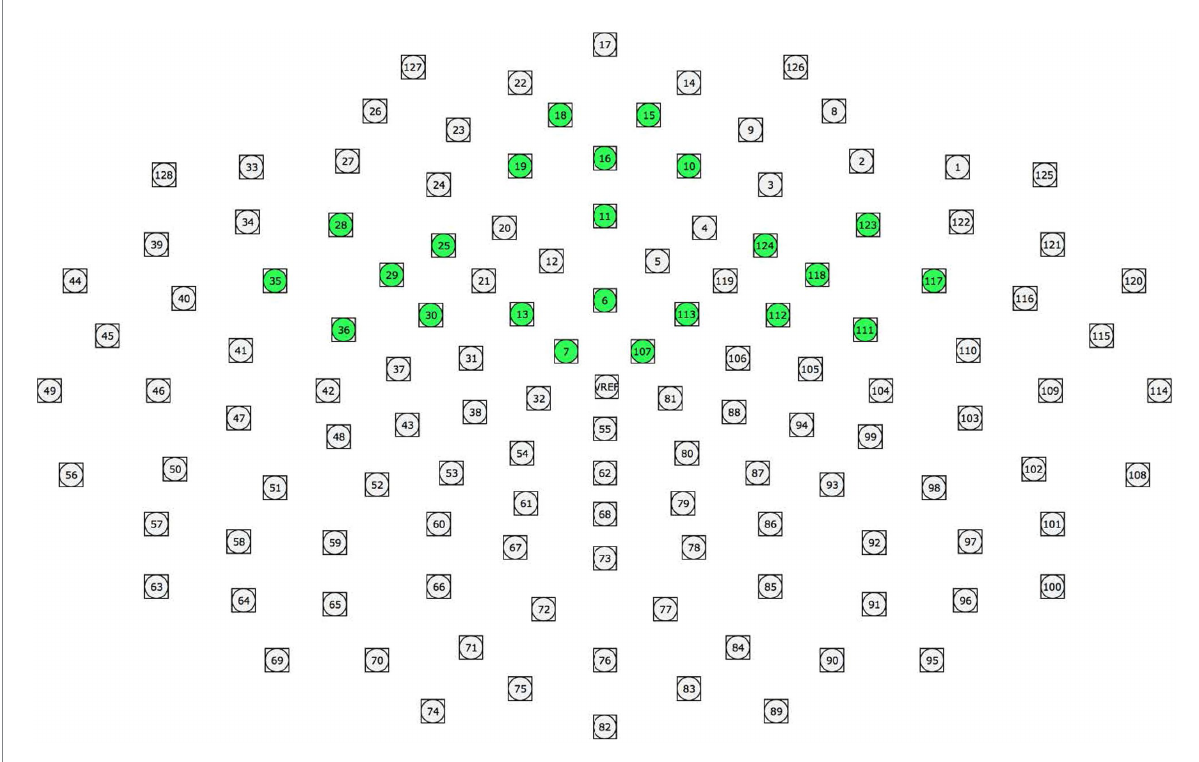
FIGURE 1 ERP clusters used in data analyses. Clusters were created to represent the electrophysiological response to stimuli in different scalp regions. ERP data collected from the individual sensors were averaged together to represent the electrophysiological activity at the following scalp locations: Prefrontal (18, 15, 19, 16, 10, 11), Right Frontal (123, 124, 118, 112, 111, 117), Left Frontal (28, 25, 29, 30, 36, 35), and Central (13, 6, 113, 7, 107).